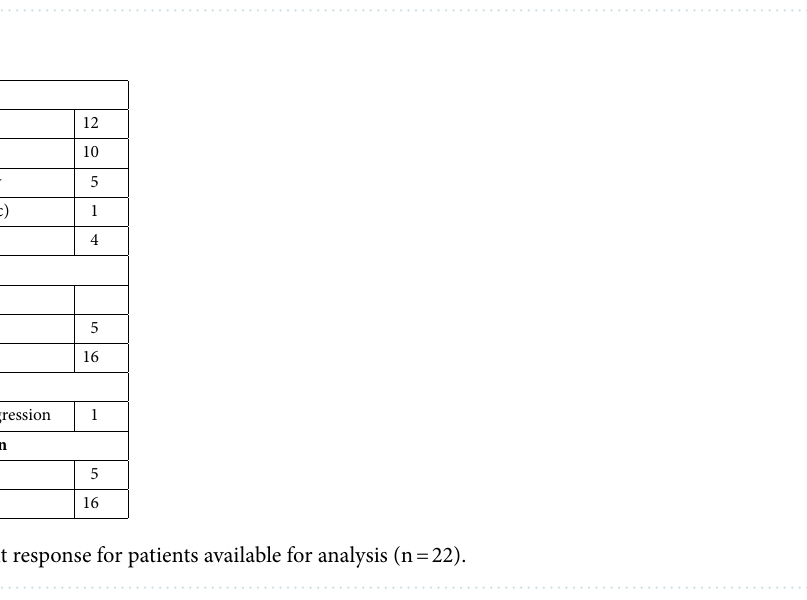
Table 1. Baseline patient characteristics (n = 24).